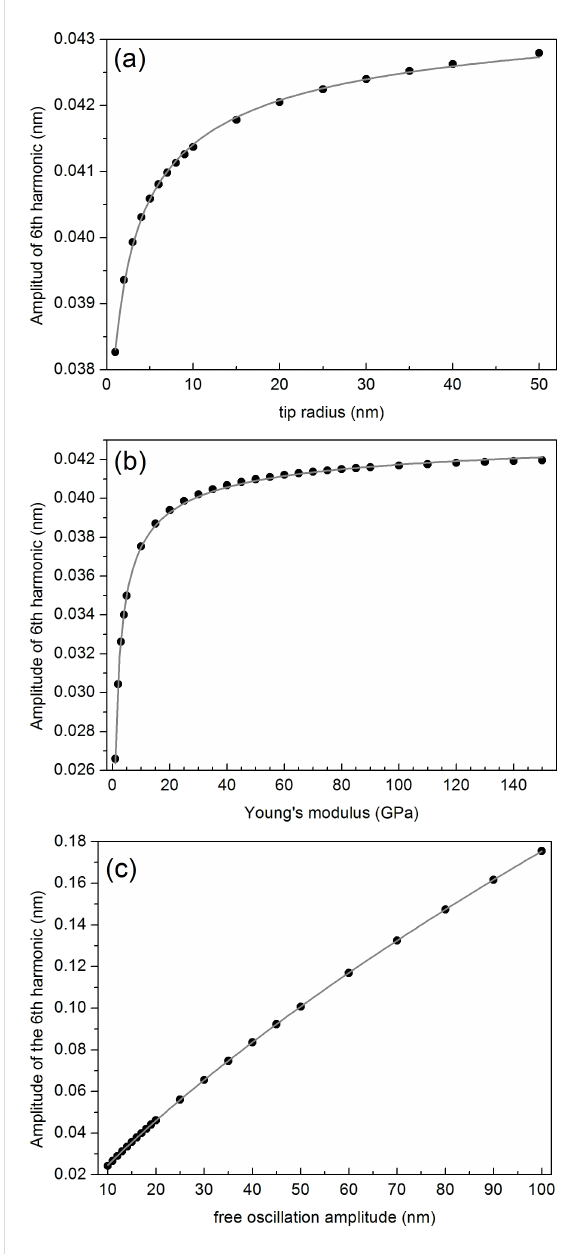
Figure 3: Simulated dependence of the amplitude of the 6th harmonic as a function of selected values of cantilever force constants. The chosen commercial cantilevers are: RTESP-150 (BRUKER) ( f = 150 kHz, L = 125 μ m, W = 35 μ m), Q = 250, k c = 5.5 N/m; 200AC- NA ( μ MASCH) ( f = 150 kHz, L = 200 μ m, W = 40 μ m), Q = 330, k c = 9.6 N/m; PPP-SEIH (NANOSENSORS) ( f = 130 kHz, L = 225 μ m, W = 33 μ m), Q = 490, k c = 15.1 N/m; RFESPA 190 (BRUKER) ( f = 190 kHz, L = 225 μ m, W = 40 μ m), Q = 550, k c = 35.3 N/m; RTESP-300 (BRUKER) ( f = 300 kHz, L = 125 μ m, W = 40 μ m), Q = 570, k c = 40.1 N/m; LTESP (BRUKER) ( f = 190 kHz, L = 225 μ m, W = 38 μ m), Q = 590, k c = 47.8